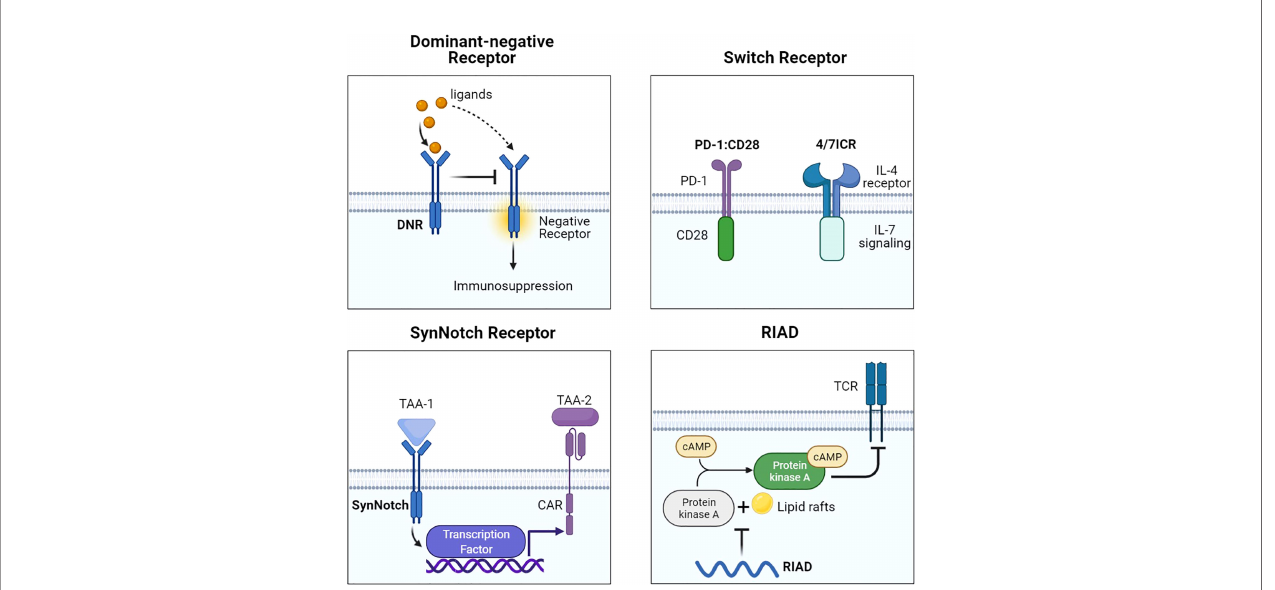
FIGURE 3 | Representative designs of CARs with different receptors and modi fi cations. Diagrams of CAR with different receptors and modi fi cations. DNR avoided the suppressive signal by competing with negative receptors such as PD-1 and TGF- b R. Switch receptors converted the suppressive signal into activation signaling. SynNotch could increase antigen speci fi city by recognizing another TAA. RIAD inhibited the combination of PKA and cAMP to protect TCR. Figure created using BioRender.com.